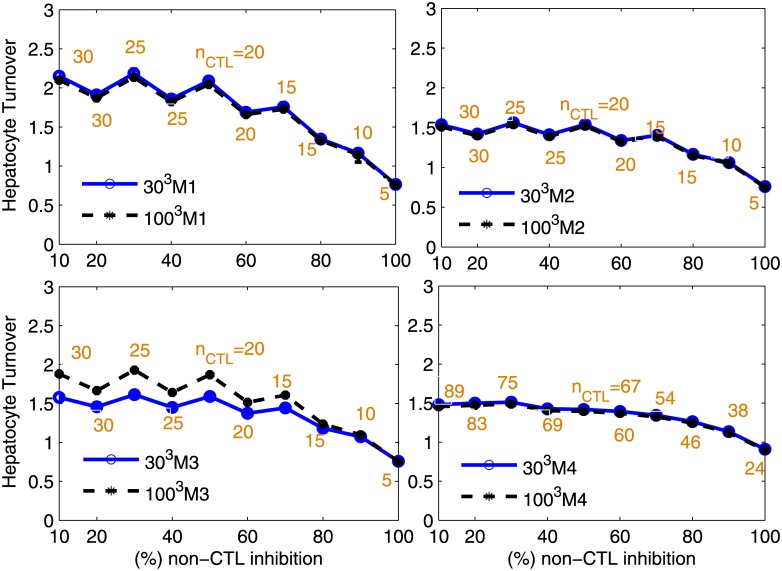
Relation between different CTL mechanisms, non-CTL inhibition and HT during infection clearance.Simulations were performed with weak CCT and under different lattice sizes to determine its impact. The T cell clearance number (nCTL) is shown as brown text at each data point under the different mechanisms of cytolytic killing, (A) Mechanism 1 (M1), (B) Mechanism 2 (M2), (C) Mechanism 3 (M3), and (D) Mechanism 4 (M4). In the figure legends, 303M1 and 1003M1 refer to simulations conducted with N = 303 and N = 1003 hepatocytes under mechanism 1. The higher is non-CTL inhibition the fewer CTLs are required to clear infection as represented by lower nCTL. As non-CTL inhibition increases in strength, the number of cells required to be killed by each CTL (nCTL) to achieve clearance either remains constant or decreases. For a given non-CTL inhibition, an nR higher than nCTL will also clear infection with lower HT. The peaks are an artefact of restricting calculations of nCTL to multiples of 5 for M1, M2 and M3.